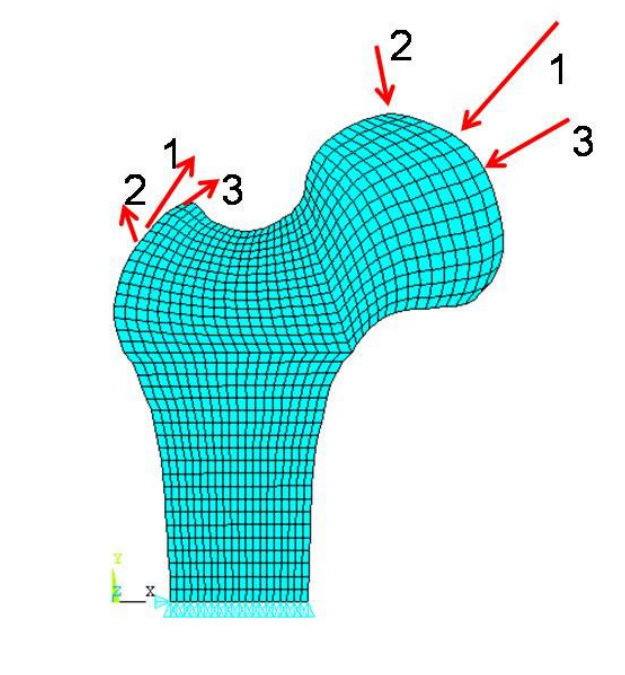
Fig. 3 Bone loadings without a